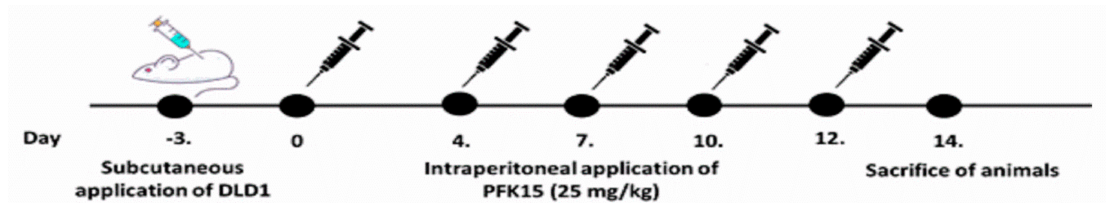
Figure 9. Experimental in vivo procedure for PFK15 administration. Nude mice bearing xenografts were intraperitoneally treated with PFK15 at 25 mg/kg a total of five times over 2 weeks. Animals were sacrificed on day